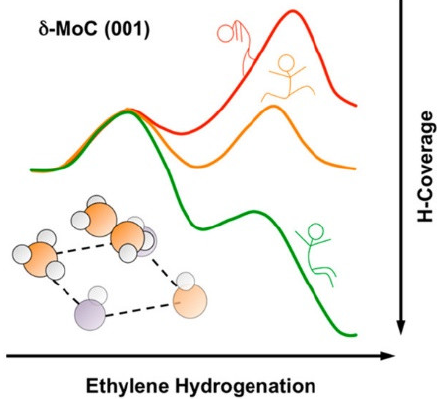
Figure 4. The relationship of hydrogen coverage and ethylene hydrogenation with the δ-MoC (001) catalyst through figurative imagery [78]. Copyright 2020, American Chemical Society.